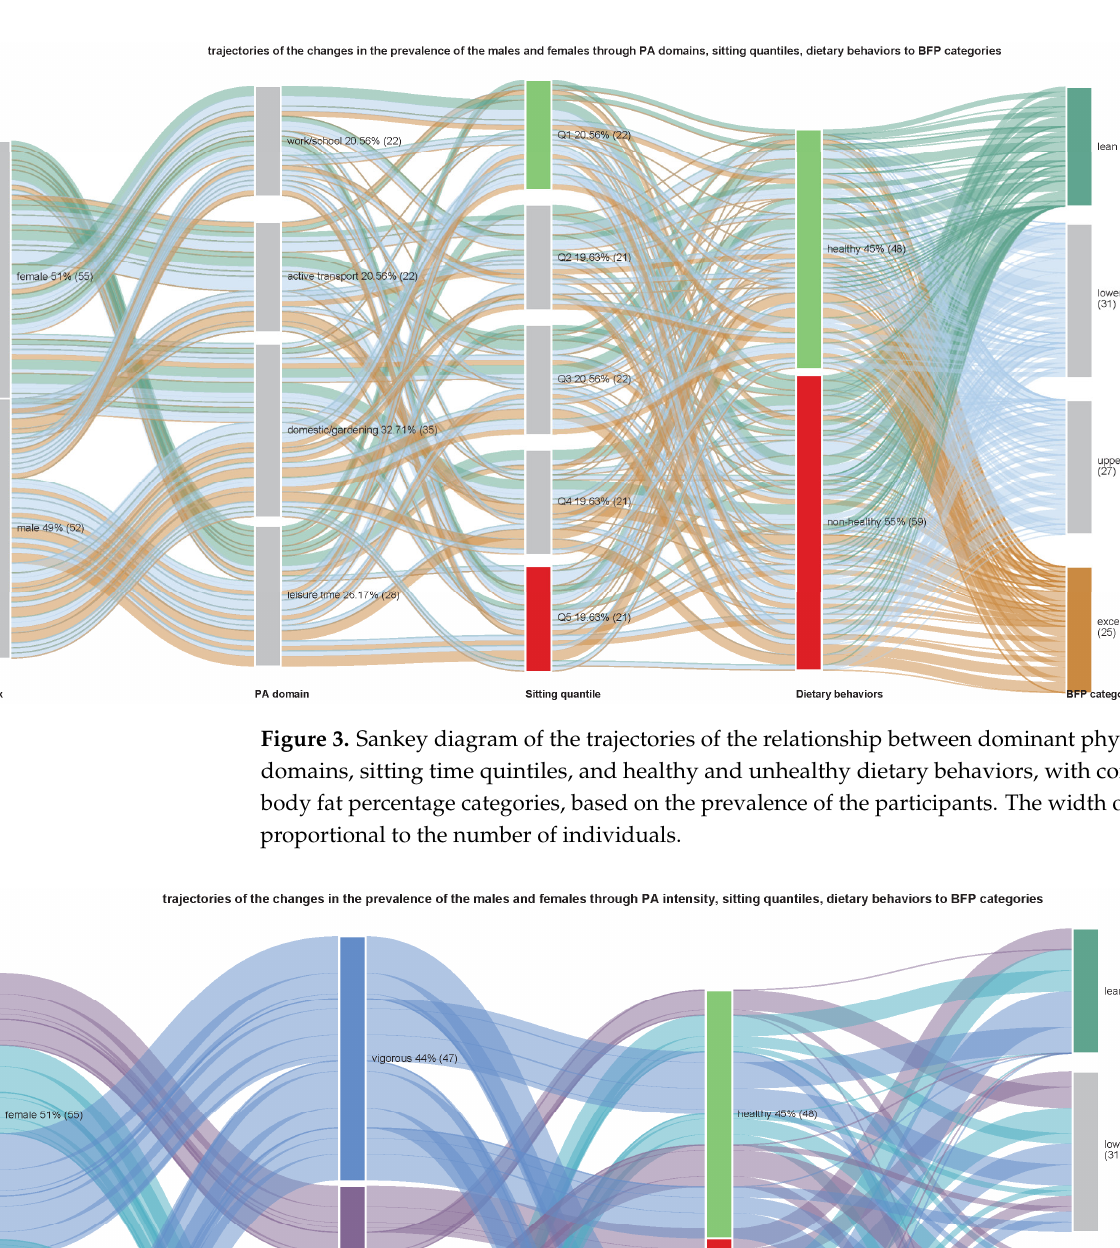
Figure 5. Cluster analysis of the groups of lean, lower normal, upper normal, and excessive fat par- ticipants based on the best-discriminating subset of variables (active transport, leisure time, walking intensity, and healthy dietary behaviors). 3.2. The Set of Physical Activity and Dietary Behaviors That Effectively Distinguished between Lean, Normal, and Excessive Fat Groups Based on the results so far, it was reasonable to look for a set of PA and DB variables that differentiate individuals with different levels of adiposity the most. Standardized mean values with 95% CI are presented in Table 1. The results of the discriminant analysis are presented in Table 2.